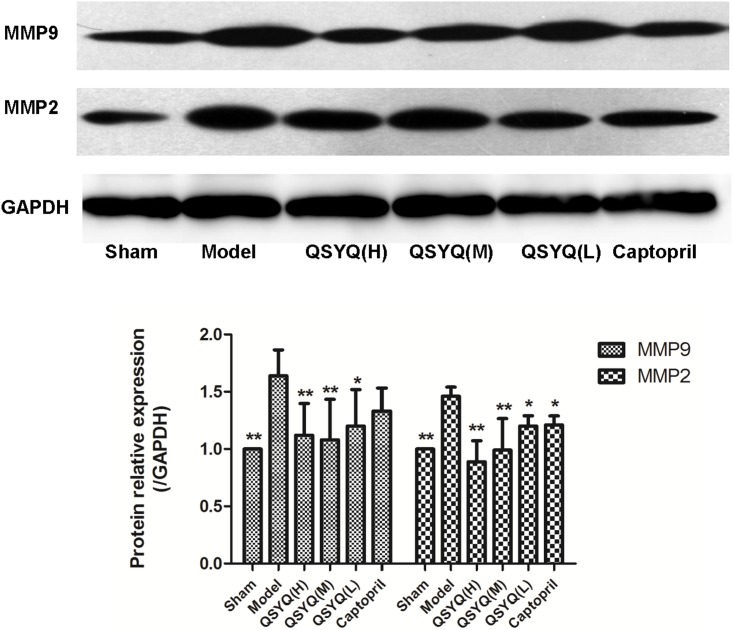
QSYQ treatment significantly decreased cardiac MMP-2 and MMP-9 in rats with HF.MMP-2 and MMP-9 were remarkably up-regulated in model group, indicating elevated degree of remodeling changes. QSYQ (H) greatly suppressed myocardial hypertrophy and remodeling by MMP-2 and MMP-9. QSYQ (M) and QSYQ (L) can also play the same effect. The captopril only suppressed expression of MMP-2, without significant effect on MMP-9. n = 10∼14 for each group. Data were analyzed by one-way ANOVA, with p<0.05 indicating statistical significance. *p<0.05 and **p<0.01 vs. model group.